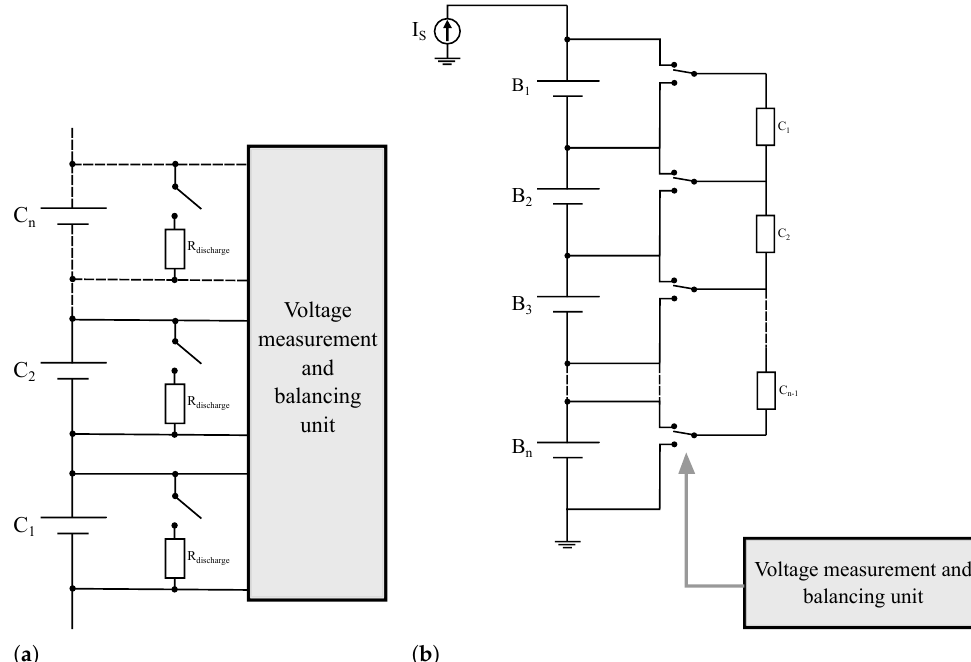
Figure 11. Scheme of passive and active cell balancing. ( a ) Passive cell balancing. ( b ) Active cell